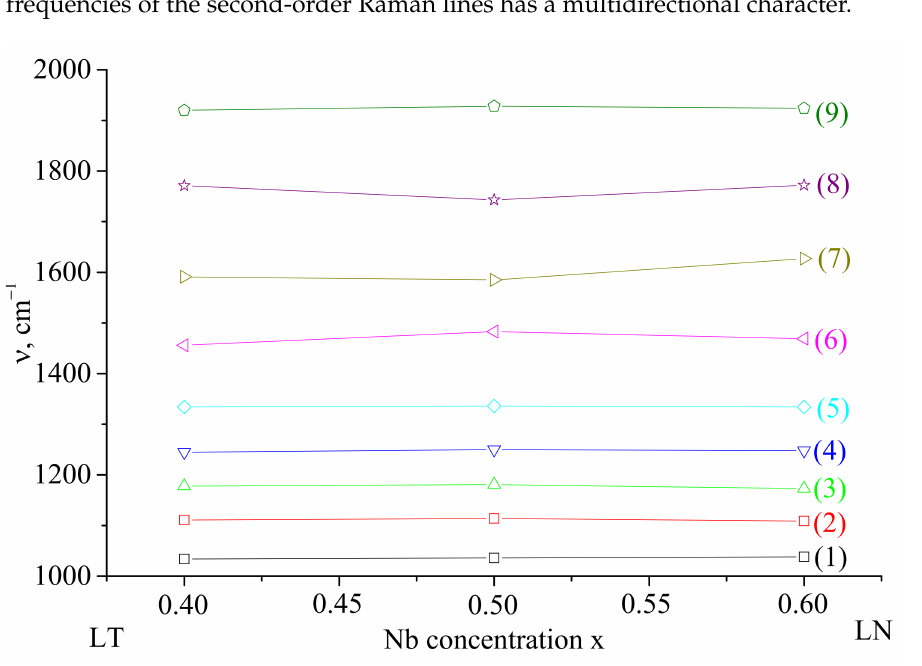
Figure 4. Dependence of second-order Raman lines frequency on the composition of LNT ceramic solid solutions. Lines (1–9) correspond to the frequencies of Raman lines marked in Figure 3a–c in the region of 1000–2000 cm − 1 : (1)-1034, (2)-1111, (3)-1178, (4)-1245, (5)-1334, (6)-1456, (7)-1591, (8)-1771 and (9)-1920 cm − 1